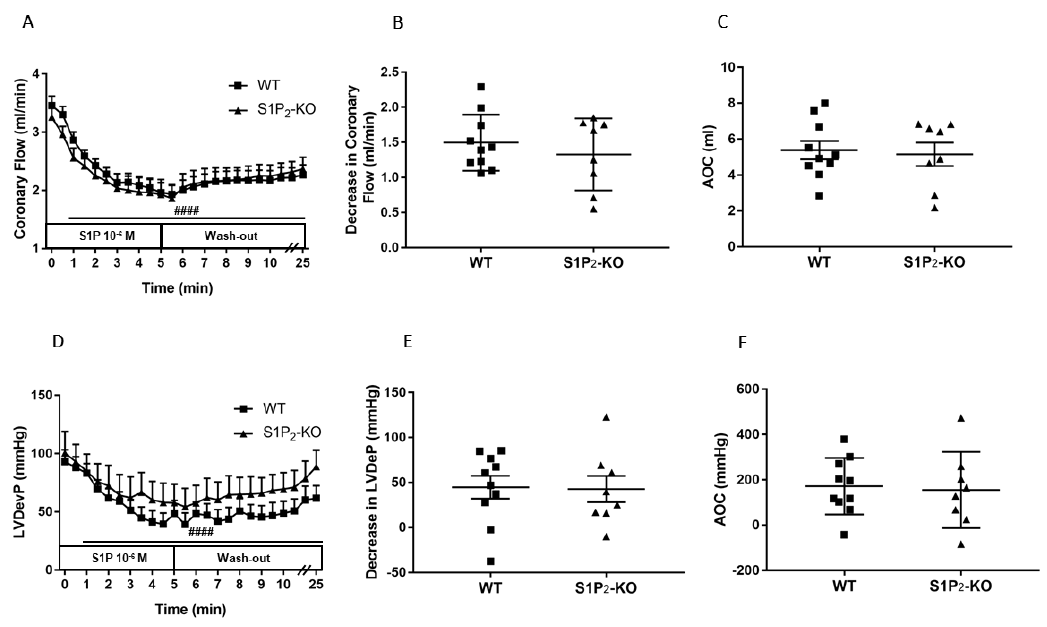
Figure 3. Effects of S1P on coronary flow (CF) ( A – C ) and left ventricular developed pressure (LVDevP) ( D – F ) of hearts isolated from wild-type (WT) and S1P 2 knock-out (KO) mice. S1P (10 − 6 M) was administered to the perfusate of isolated WT and S1P 2 -KO murine hearts for 5 min. The infusion was followed by a 20-min wash-out period. CF and LVDevP were monitored during the entire experiment (panels A and D). Maximal decrease in CF and LVDevP compared to preinfusion baseline are shown in panels B and E. Values of area over the curve (AOC) during S1P infusion are shown in panels C and F. In S1P 2 -KO hearts S1P-induced CF and LVDevP reduction was similar to that observed in WT hearts. Mean ± SEM; n = 10, 8; #### p < 0.0001 vs. baseline (preinfusion value) in both groups, two-way repeated measurement ANOVA followed by Dunnett’s post hoc test.